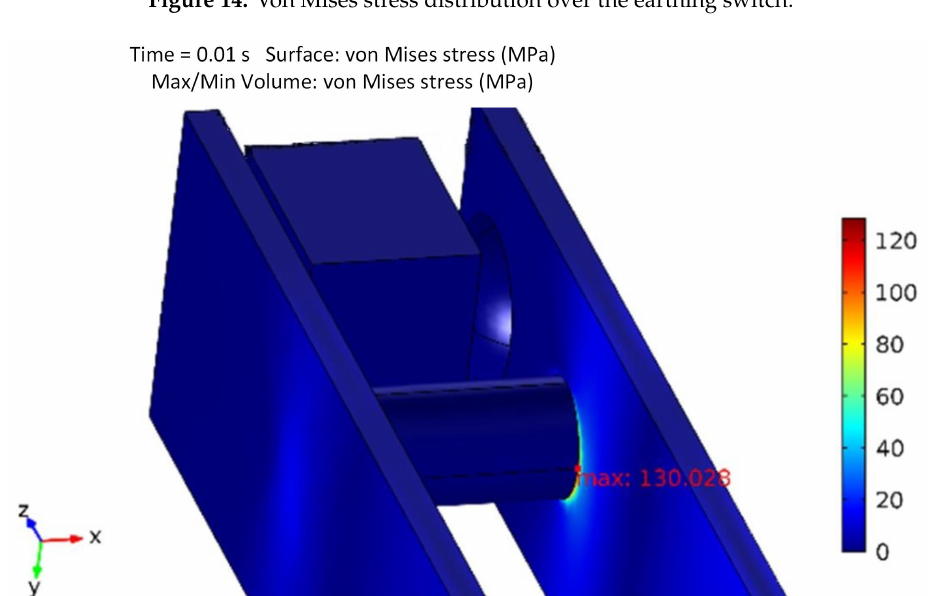
Figure 15. Phase L1—knife L12—the point of maximum Von Mises stress-red